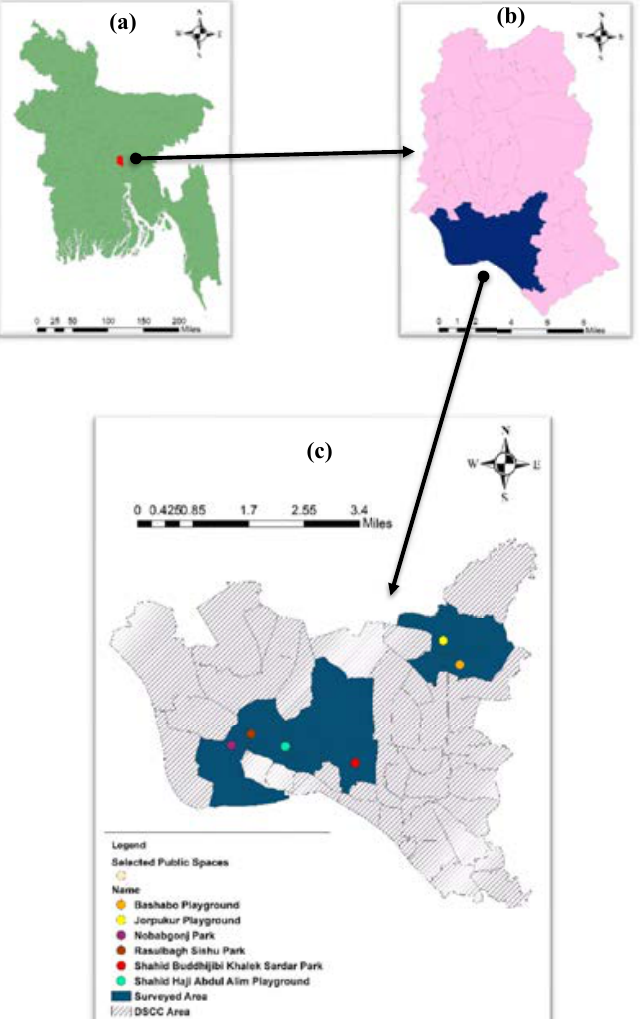
Fig. 1: Geographic location of the study area; (a) Bangladesh, (b) Dhaka City and (c) Dhaka South City considered only old jurisdiction areas of DSCC.